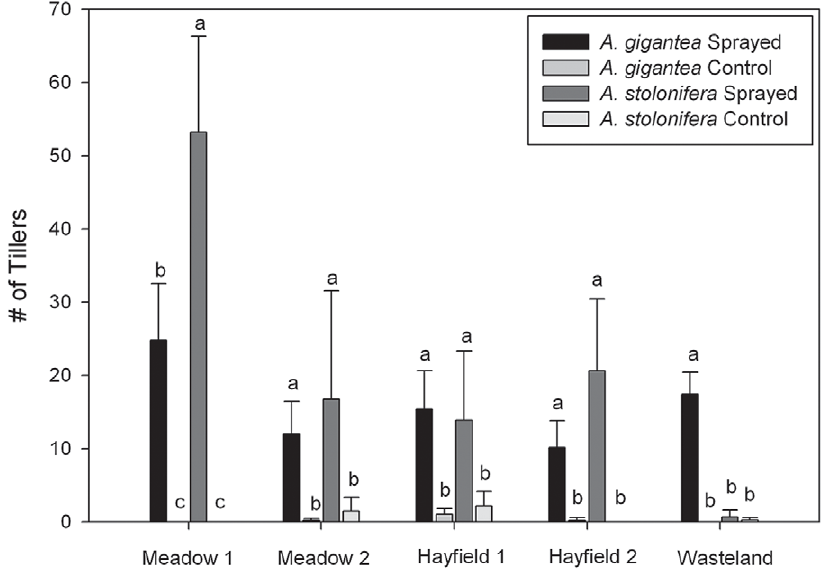
Figure 3. Number of tillers on creeping bentgrass (CB) and redtop (RT) plants in the last year of the field study (May, 2010). Error bars indicate SD and letters indicate differences within plot location at according to Fisher’s LSD test ( a ,